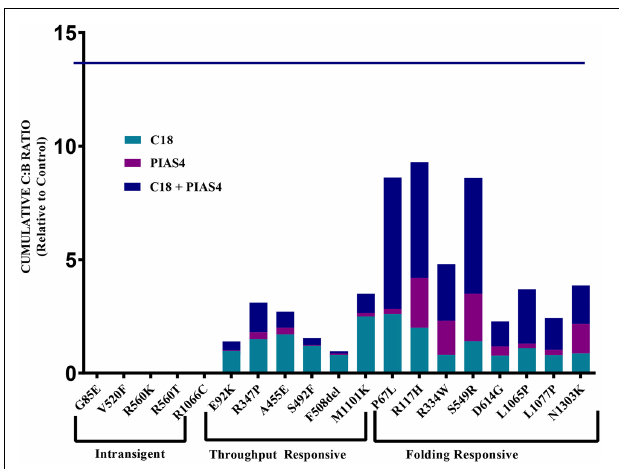
FIGURE 6 | Cumulative C:B ratio for all groups. The C:B ratio for each treatment, relative to control, shows patterns of responses in each of the identified groups. The Intransigent group showed no band C production. The throughput responsive group shows some band C production, but the C:B ratio for C18 + PIAS4 was less than that due to C18 alone. In the folding responsive group, the C:B ratio for PIAS4 + C18 was greater than that due to C18 alone, indicating that C18 produced folding beyond that expected from the PIAS4-induced production of band B. The horizontal line at 13.8 on the ordinate represents the C:B ratio of wild-type CFTR for comparison.